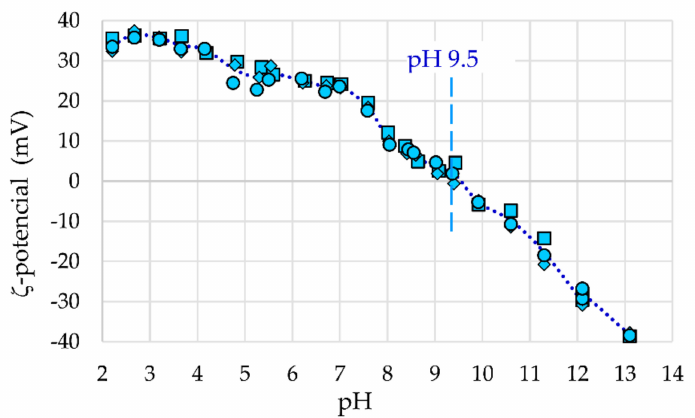
Figure 7. The ζ -potential for γ -Fe 2 O 3 -(NH 4 OH)@SiO 2 (APTMS) NPs.